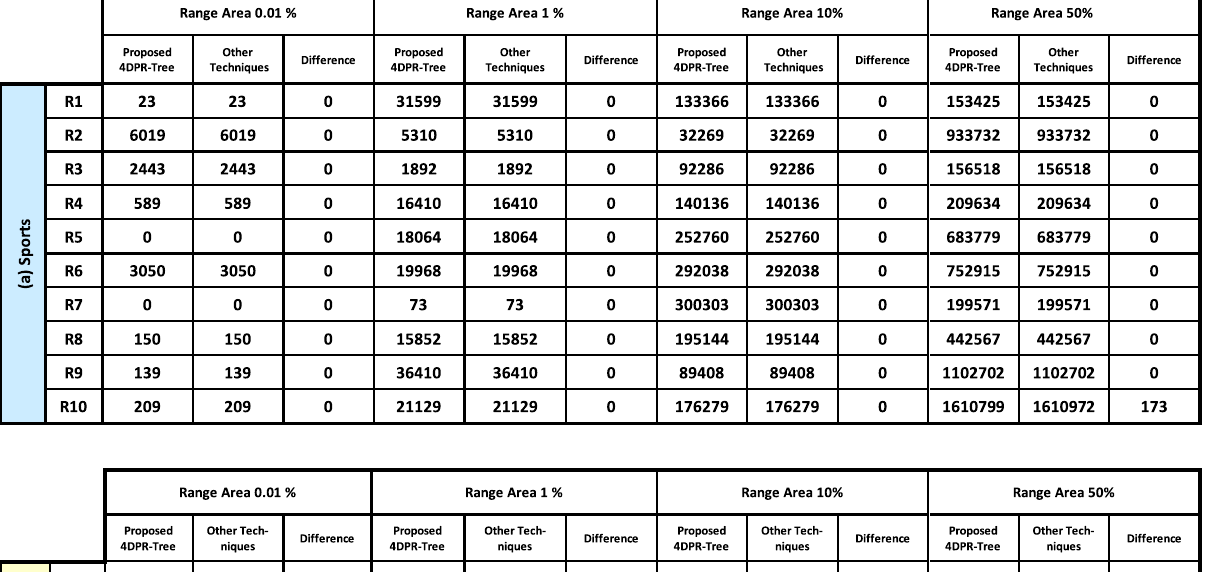
Table 3 Difference between returned objects of the proposed MBR-aware PR-Tree and other techniques on indexed real datasets (a) Sports, (b) Cities, (c) Lakes, and (d)